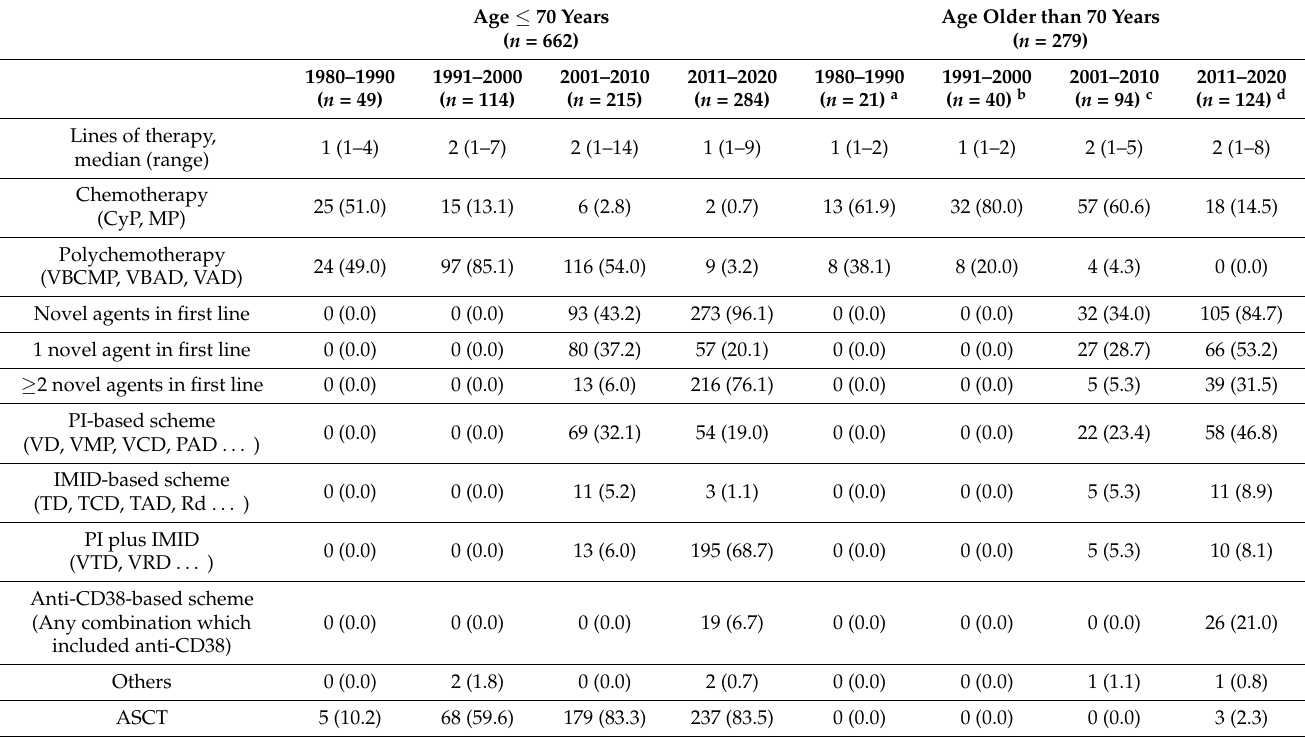
Table 2. Treatments used by age and decade of